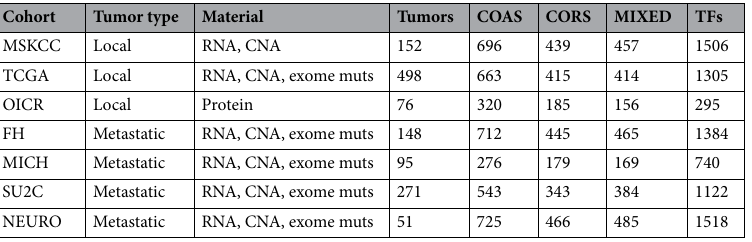
Table 1. Summary of the prostate cancer cohorts. The number of tumors and the number for genes detected from each category in the unique gene lists (TFs (n = 2662); coactivator (COA; n = 766); corepressor (COR; n = 599); mixed function coregulator (MIXED; n =